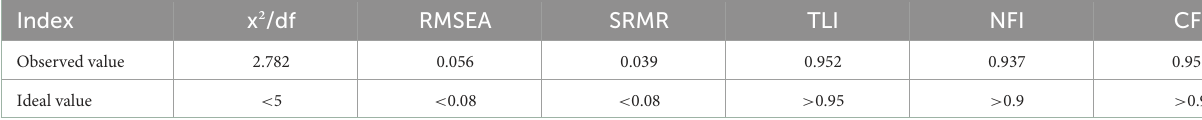
TABLE 6 Model fitting indexes after